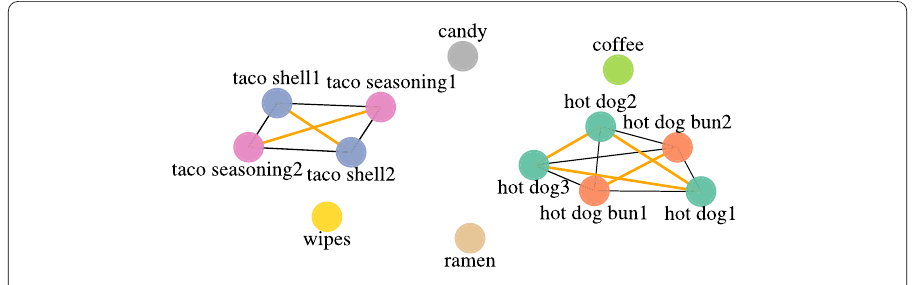
Figure 6 The unipartite network in the illustrative example, with product nodes connected by both the complementarity scores ( W ( c ) ) (in black) and the substitutability scores ( W ( s ) ) (in orange) induced by the ij ij original measure, where the line thickness corresponds to how high the scores are, and products in the same substitute role are shown in the same colour